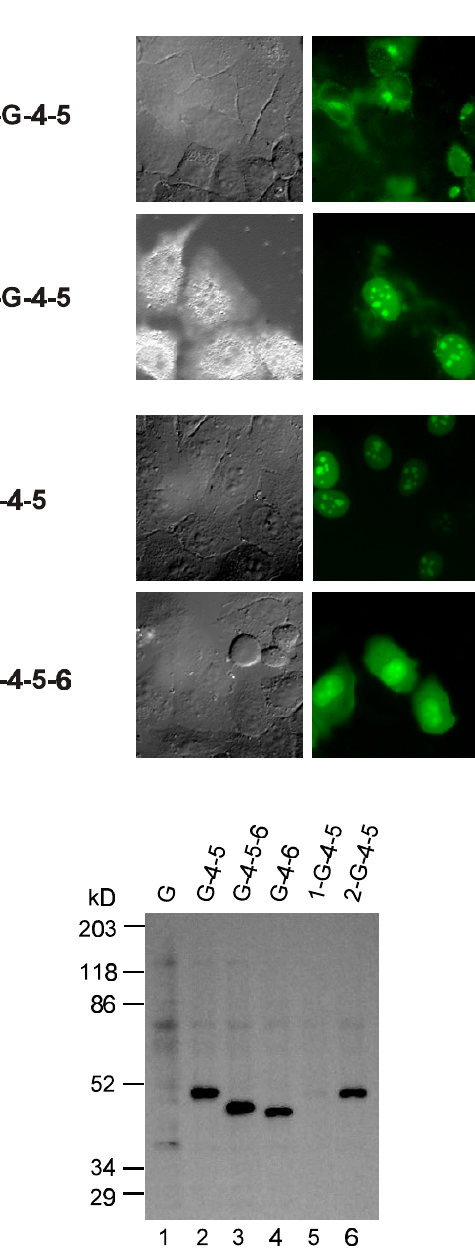
Figure 5 (A) The mature IGF-I domain is not required for nucleolar localization, while replacing the C-terminal part of the E domain encoded by exon 5 results in loss of specific nucleo- lar localization. The left panels are phase images except for 2- G-4-5 which was saved as a pseudo-DIC image instead. (B) Western blot of lysates from transfected cells using an anti- GFP antibody. The identity of the transfected chimera is given above the lanes. Positions of the size markers are given on the